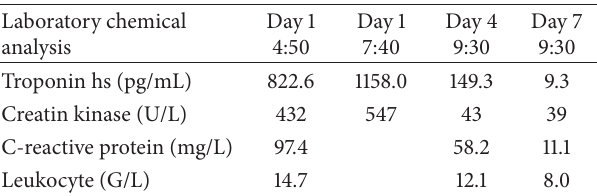
Table 1: Initial and follow-up biochemistry